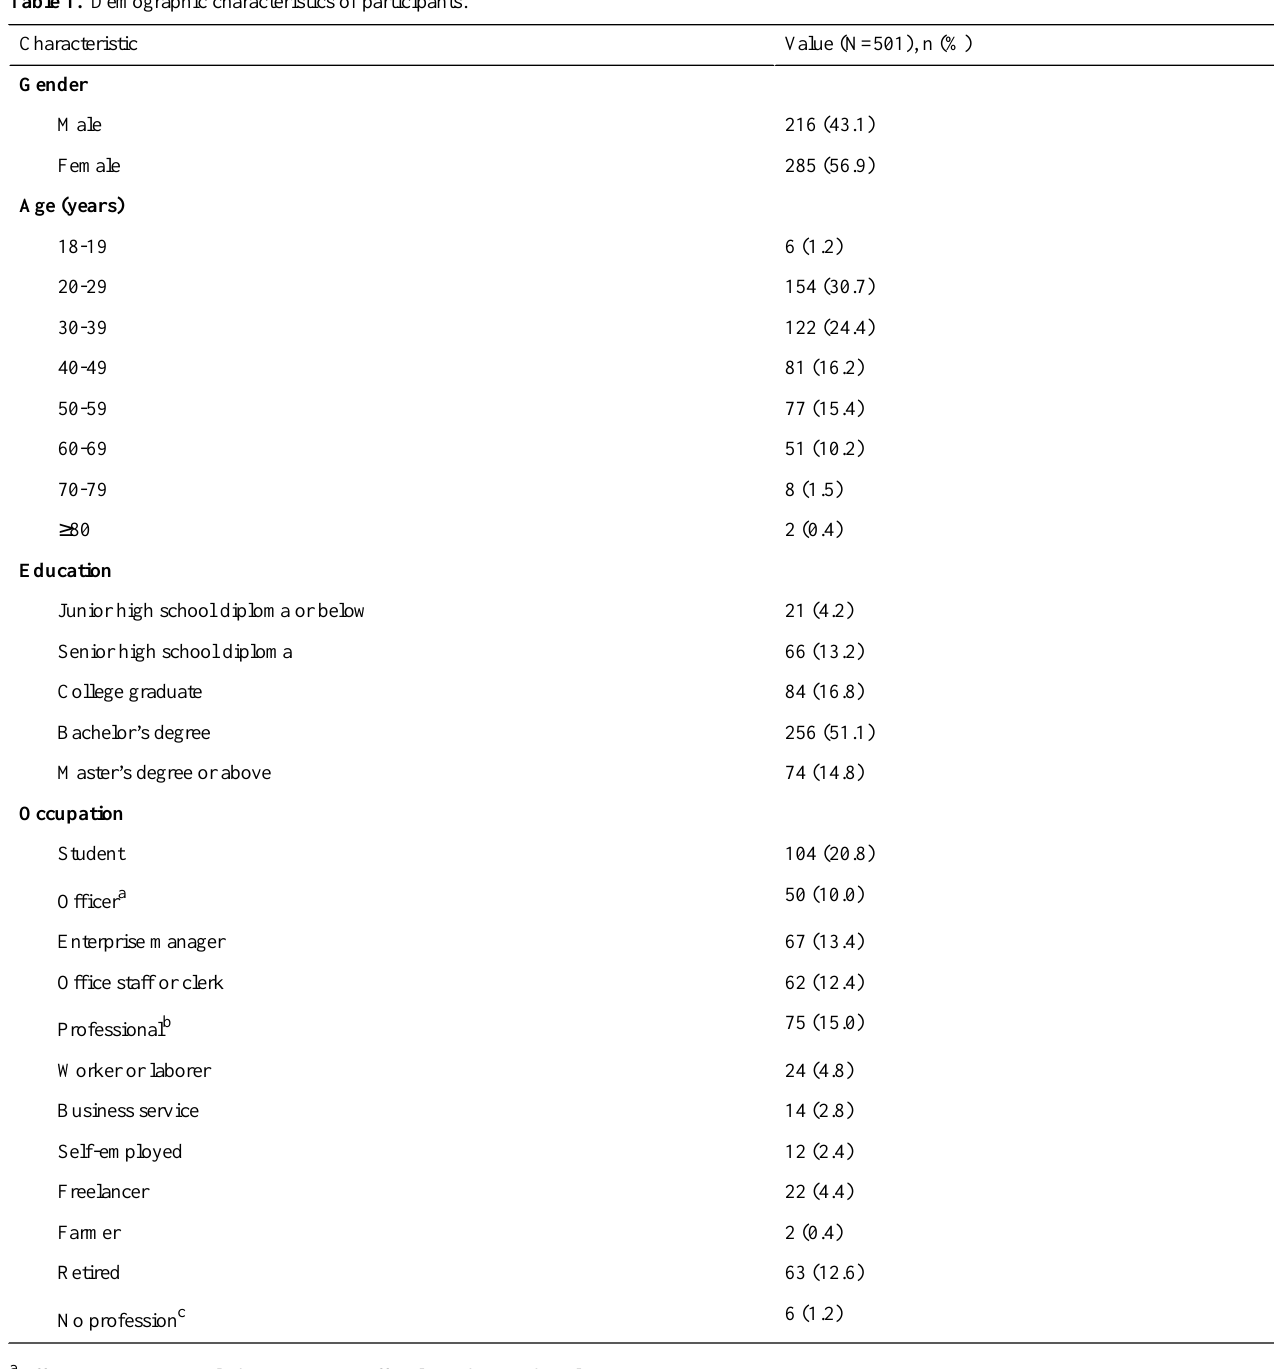
Table 1. Demographic characteristics of